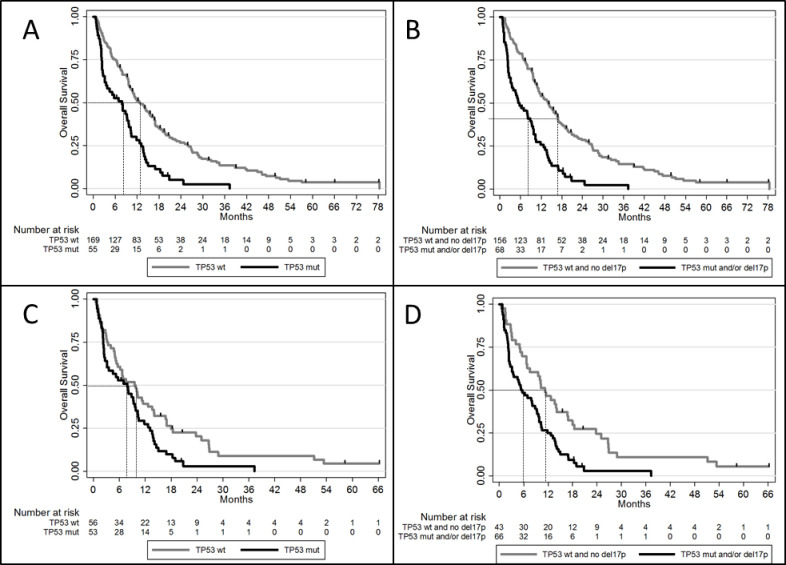
Overall survival according to TP53 alterations.A. OS in patient with TP53 mutation versus TP53wt. B. OS in patient with TP53 mutation and/or deletion versus patient without TP53 alteration. C. OS in patient with TP53 mutation versus TP53wt in the subgroup of adverse karyotype. D. OS in patient with TP53 mutation and/or deletion versus patient without TP53 alteration in the subgroup of adverse karyotype.